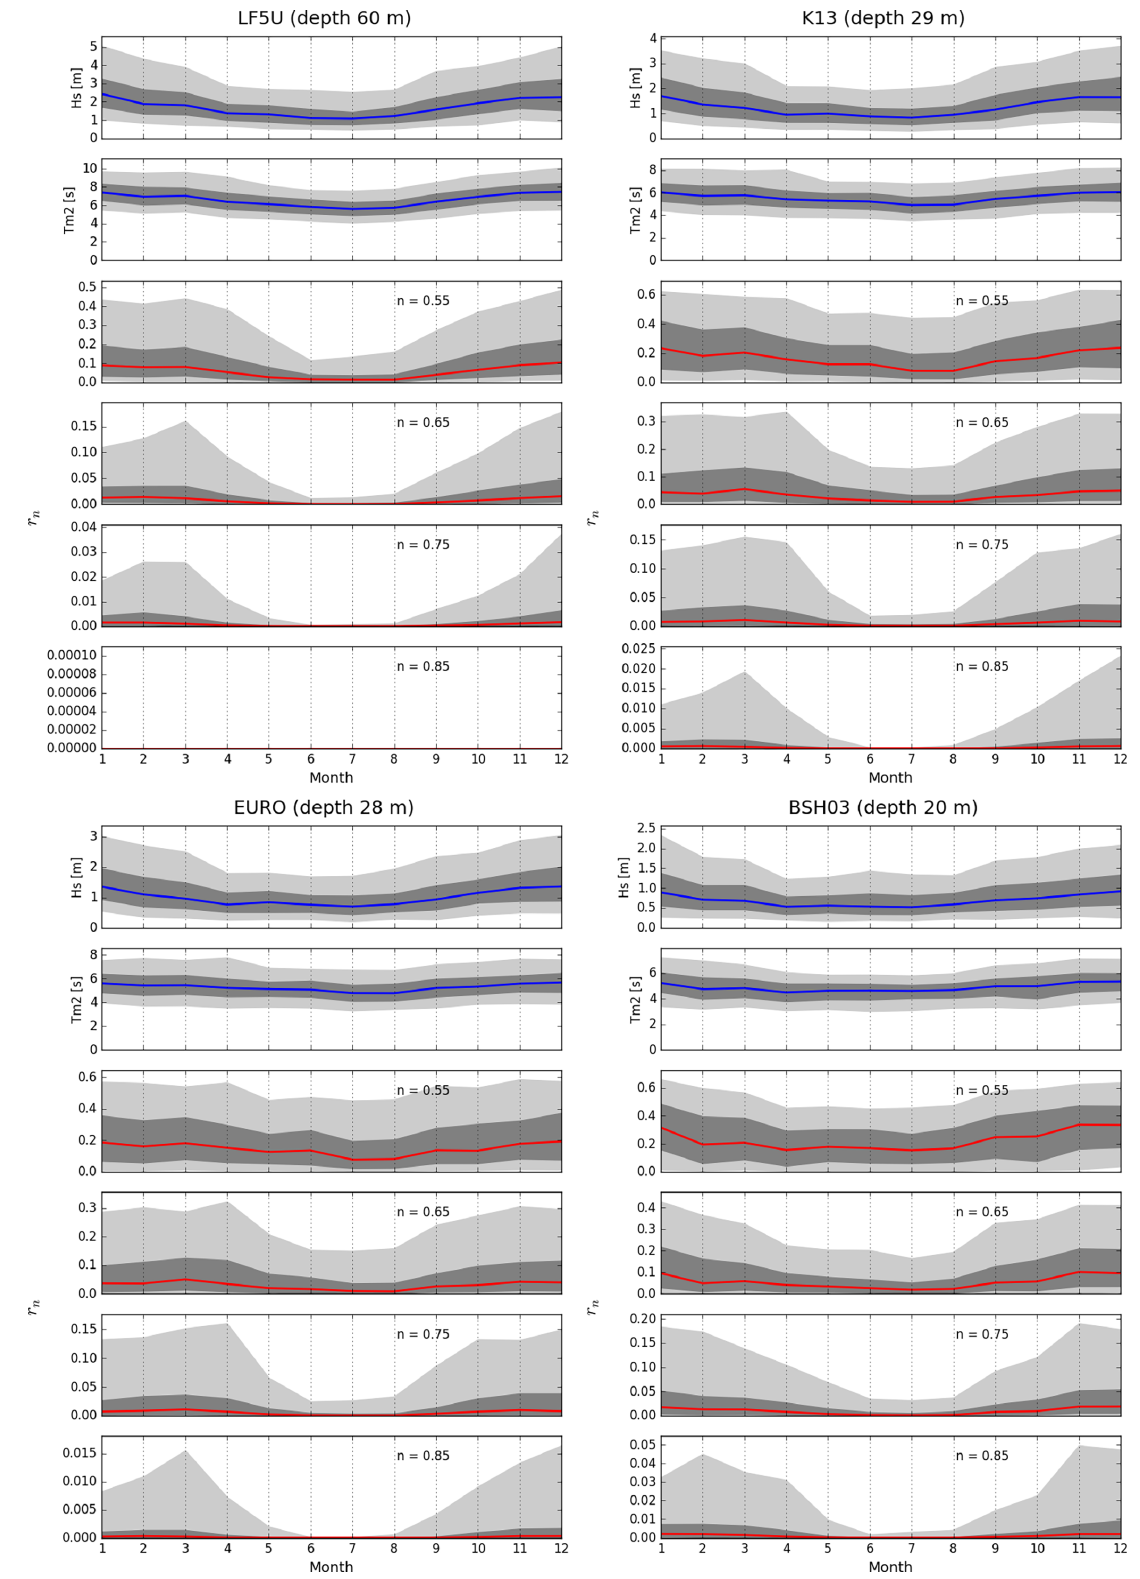
Figure 4. Same as Fig. 3 but for stations LF5U, K13, EURO, and